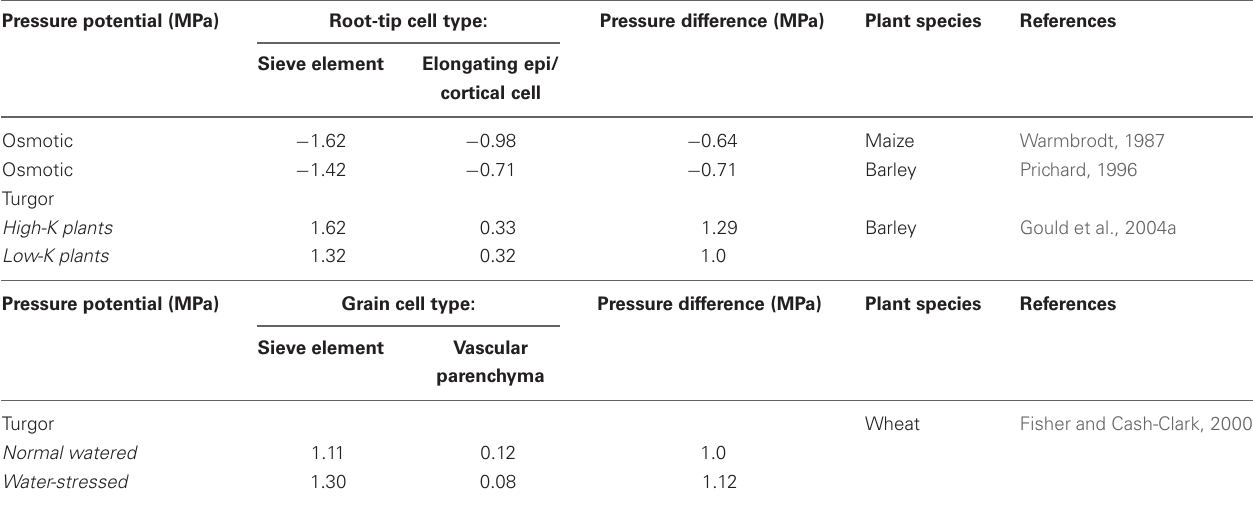
Table 2 | Osmotic or hydrostatic pressures of sieve tubes and adjoining specified cells in root tips and developing wheat